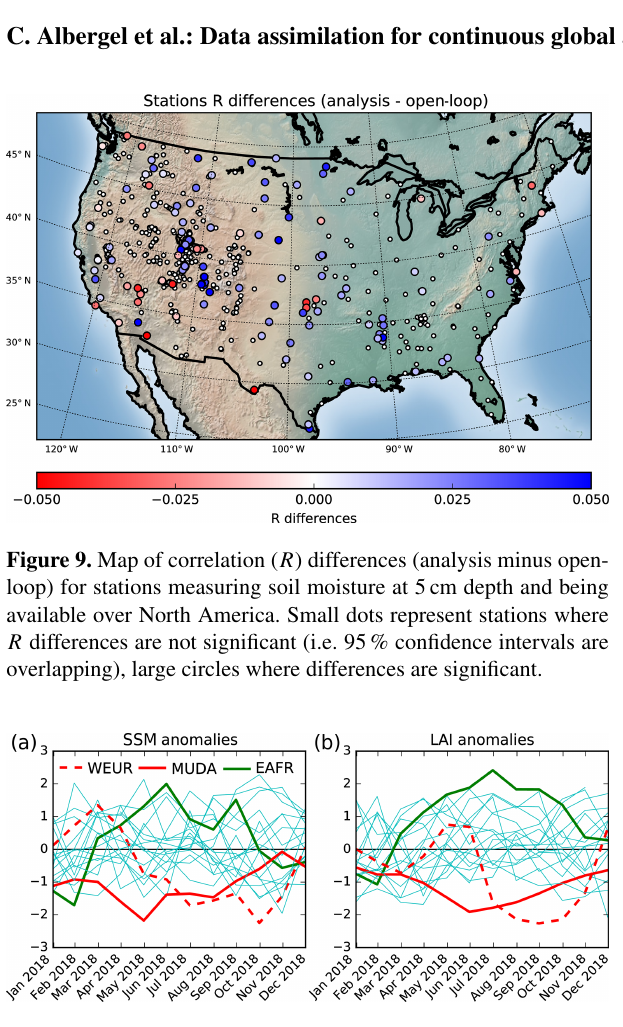
Figure 10. 2018 monthly anomalies scaled by standard deviation of analysed (a) SSM and (b) LAI, with respect to 2010–2018, for the 19 regions presented in Table 1 and Fig. 2. Solid red line, dashed red line and solid green line represent regions MUDA, WEUR and EAFR. Solid cyan line represents all other boxes (see Table 1 and Fig.